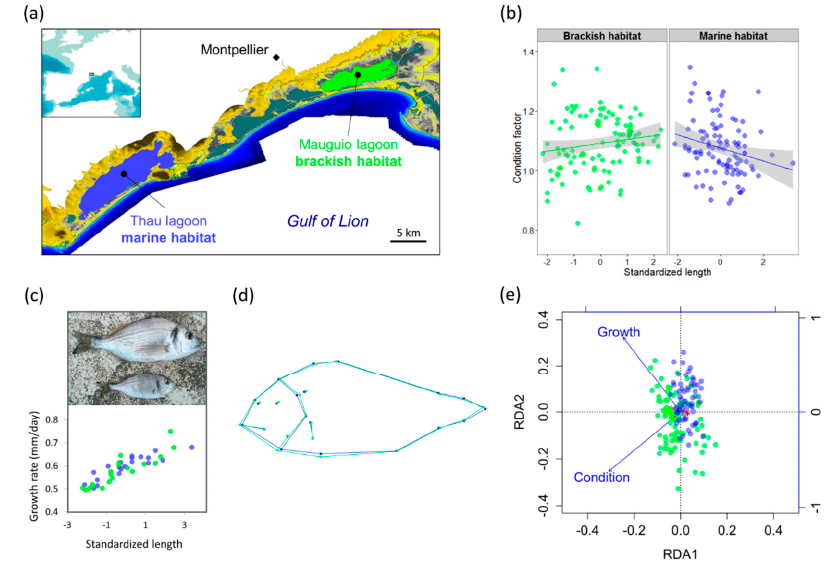
Figure 1. Phenotypic variation of juvenile sea bream from different nursery habitats. ( a ) Juveniles of the same year cohort were sampled in two closely located nursery habitats in the Gulf of Lion: a stable but low-productivity marine habitat (Thau lagoon, blue) and a stressful but highly productive brackish habitat (Mauguio lagoon, green). ( b ) Habitat-dependent correlation between individual standardized length and condition factor (ANCOVA interaction term: P = 0.003, shaded areas indicate 95% confidence intervals). ( c ) Predictive accuracy of standardized length for somatic growth rate estimated through otolith age reading in 20 individuals from each habitat ( R 2 = 0.77). ( d ) Mean body shape differences between habitats (permutation test: P < 0.001). ( e ) Partial redundancy analysis (RDA) of body shape controlling for sampling date, showing the main directions of morphological variation related to growth and